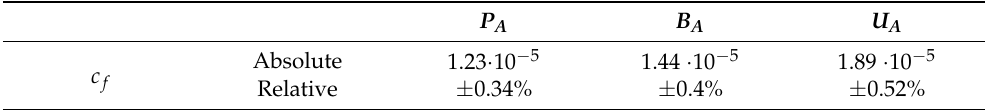
Table 4. Uncertainty in the c f with 95% confidence level at the highest speed.